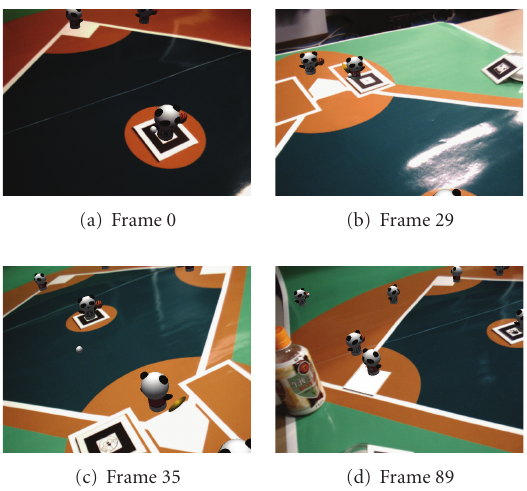
Figure 11: Closeup views of the same scenes as Figure 10 seen from di ff erent view points.